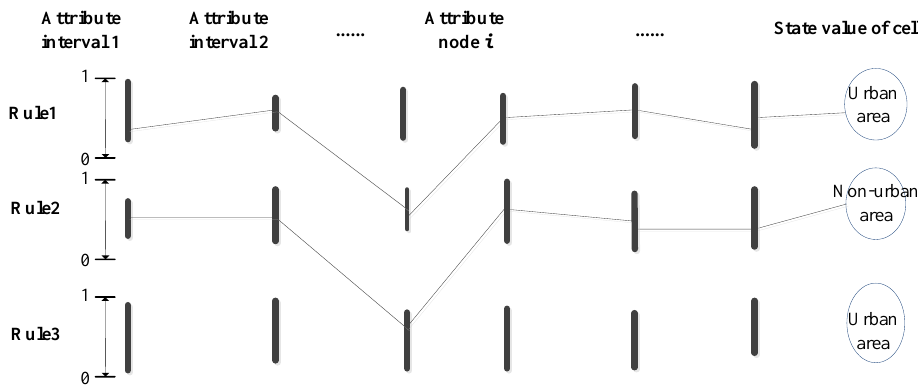
Figure 2. Schematic representation of the rule after regularization [35].